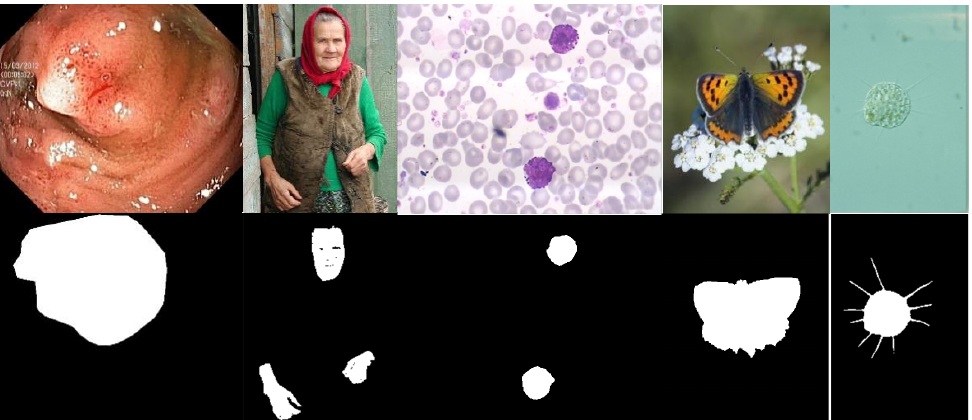
Figure 1. Samples from polyp segmentation, skin segmentation, leukocyte identification, butterfly, and microorganism identification (images and masks).